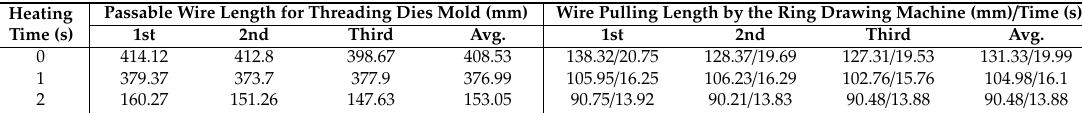
Table 14. Results based on wire pulling speed: k3(6.52 mm / s).